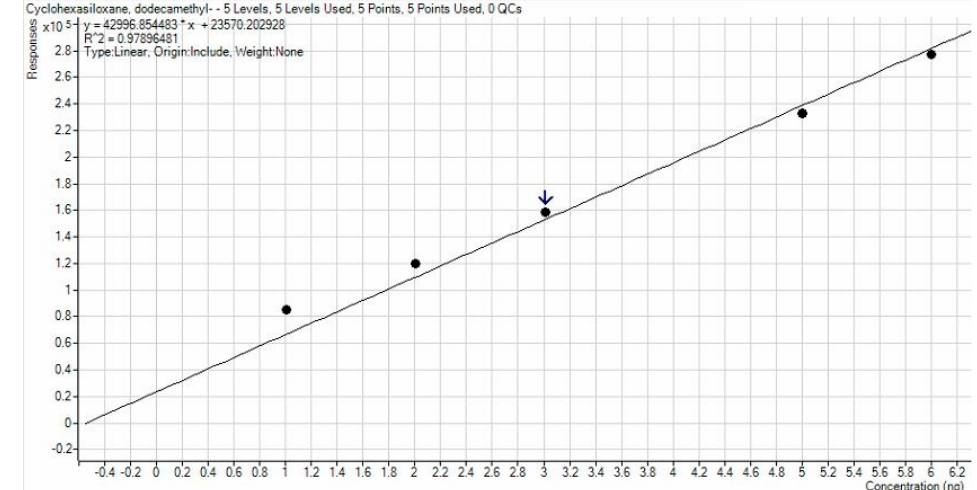
Figure 5. Calibration line for D6.